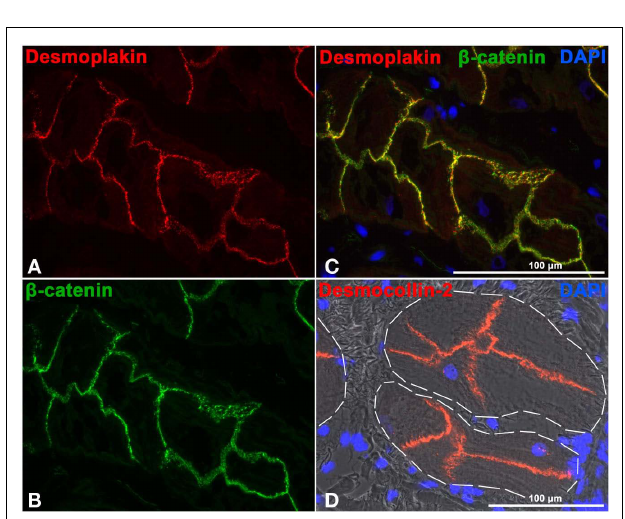
FIGURE 2 | Cryostat sections through ovine (A–C) and bovine (D) Purkinje fibers. (A–C) Double label immunofluorescence microscopy with antibodies to desmoplakin [red (A) and β -catenin green (B) ].The overlay of (A) and (B) is shown in (C) in addition to nuclear DAPI staining (blue). Note the often dotted staining pattern but high abundance of the desmosomal plaque component desmoplakin in conductive cells of the Purkinje fibers. (D) Desmocollin-2 antibody labeling (red) and DAPI staining (blue) merged with the phase contrast image.The white dashed lines demarcate the border between conductive tissue and insulating connective tissue. See also Pieperhoff et al.